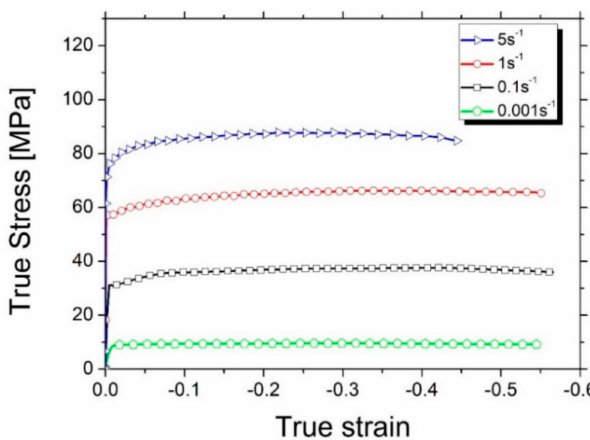
Figure 3. Flow curves for the Ti-6Al-4V alloy obtained under compression at di ff erent strain rates at 1030 ◦ C during the in-situ HEXRD